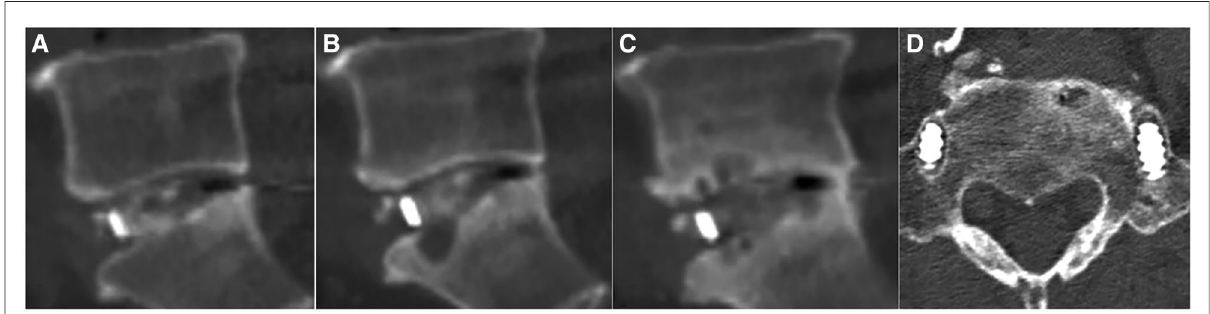
FIGURE 4 A 69-year-old Male patient with lumbar spinal stenosis underwent cage implantation. ( A ) Sagittal lumbar CT scan performed at postoperative 3 days showed good bone fi lling in the inner cage zone and no bone graft in the posterior cage zone. ( B ) CT scan performed at postoperative 3 months showed cage subsidence and educed upper and lower endplate space in the posterior zone. ( C ) CT scan performed at postoperative 2 years showed a lucent line without bone remodelling or passage of the bone trabecula in the inner cage zone. However, complete bone remodelling and passage of the bone trabecula in the posterior cage zone were observed. ( D ) Cross-sectional lumbar CT scan performed at postoperative 2 years showed loosening of the pedicle